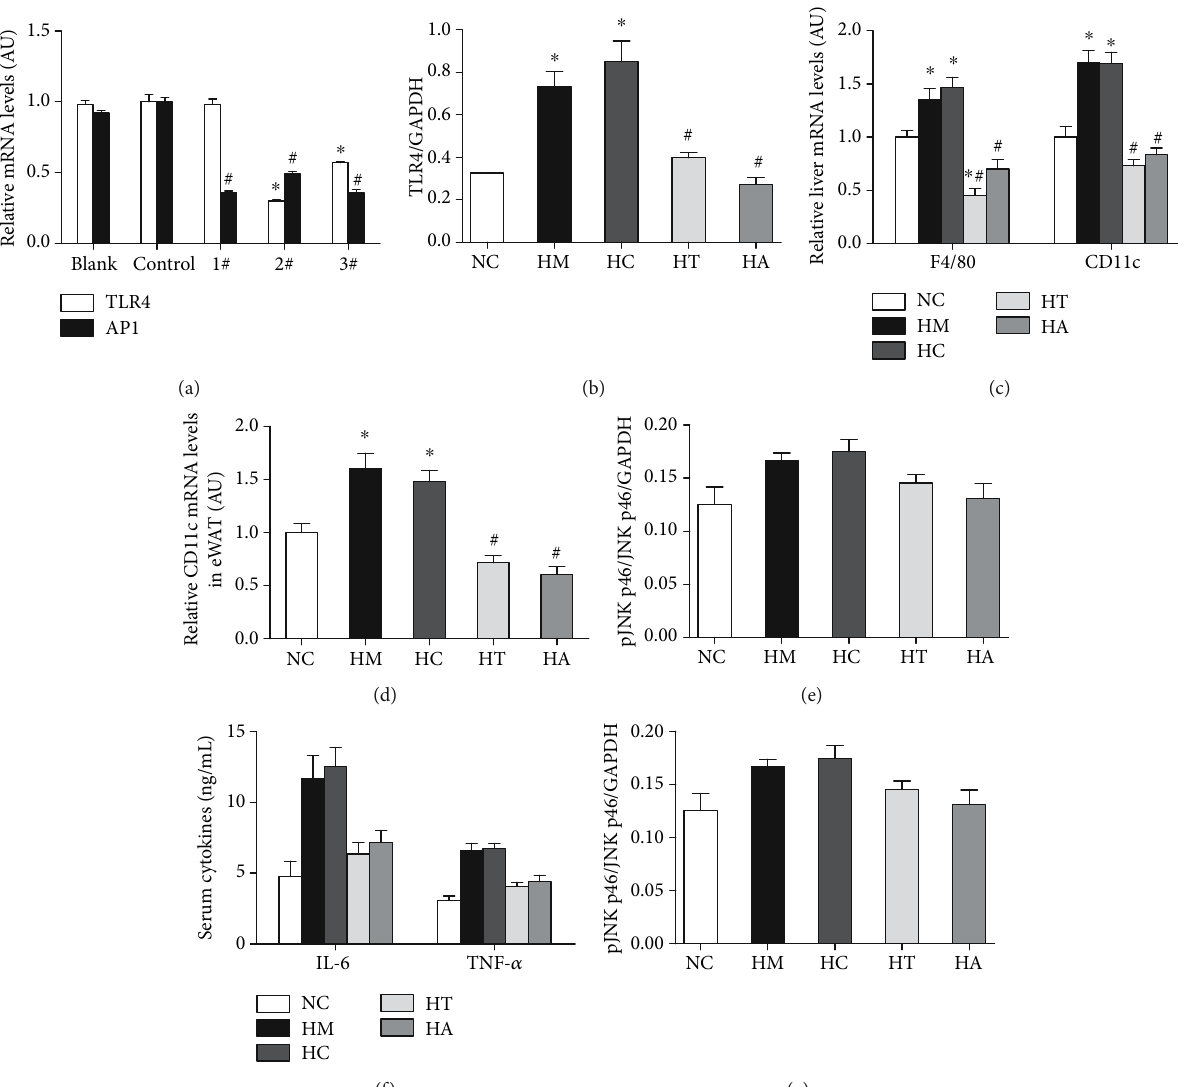
Figure 1: TLR4/AP-1 siRNA transfection alleviated systemic and hepatic in fl ammation. AP1 siRNA (1#, 2#, and 3#) and TLR4 siRNA (2# and 3#) transfection signi fi cantly down-regulated the AP1 and TLR4 mRNA expression, respectively. The decreases in the mRNA expression seemed most remarkable in 2# TLR4 siRNA and 3# AP1 siRNA transfection (a). The expression of TLR4 protein was signi fi cantly inhibited in the high-fat diet group with either TLR4 (HT) or AP1 (HA) siRNA transfection (b). The expression of F4/80 and Cd11c mRNA was upregulated in the liver of high-fat diet controls (HM) and high-fat diet controls with empty vector transfection (HC), and these changes were attenuated with either TLR4 (HT) or AP1 (HA) siRNA transfection compared with normal diet controls (NC) (c, d). No signi fi cant di ff erence was observed in JNK phosphorylation in the liver, but the serum IL-6 and TNF- α levels were elevated in HM and HC, which were attenuated in HT and HA (e, f). AMPK phosphorylation was signi fi cantly decreased in the HM and HC, and it was alleviated in HT and HA (g). ∗ p < 0 : 05 and ∗∗ p < 0 : 01 compared with the NC group; # p < 0 : 05 and ## p < 0 : 01 compared with the HM